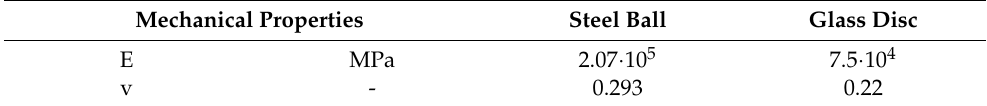
Table 2. Mechanical properties of the ball and disc.